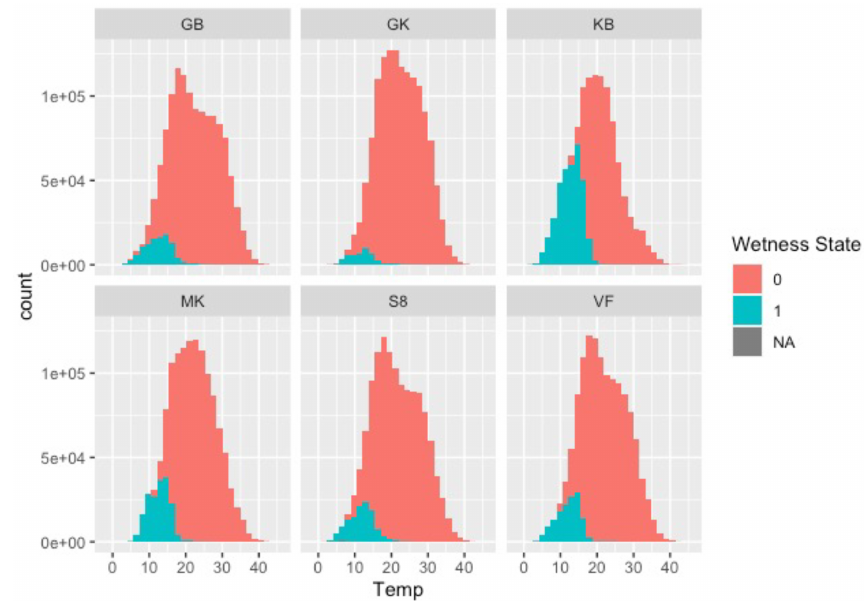
Figure A3. Frequency distributions of temperature when wet (turquoise) and dry (red) at the six sites during the study.